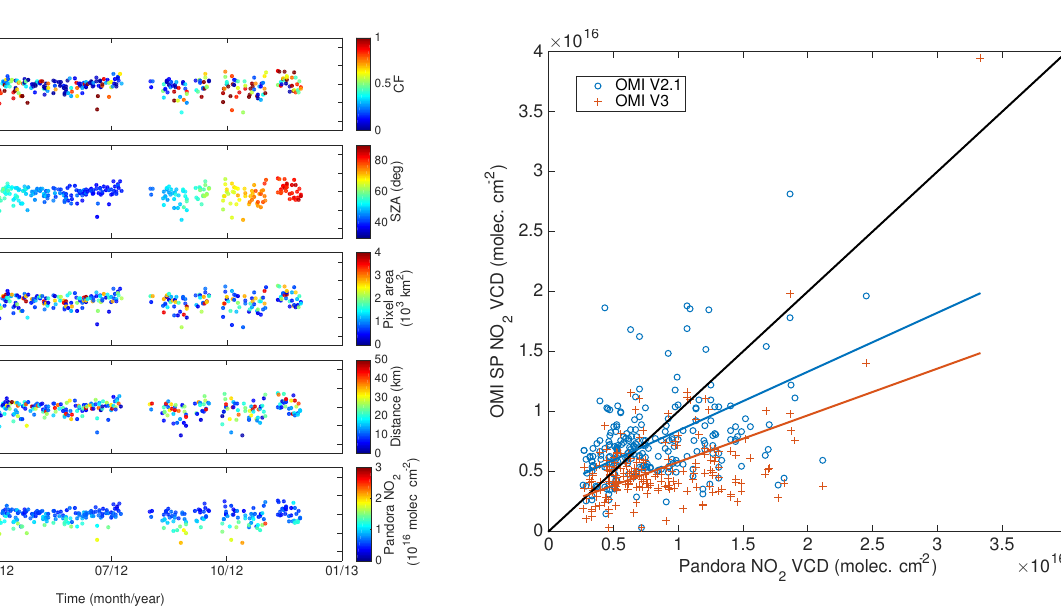
Figure 3. Difference between OMI SP and Pandora NO 2 total col- umn in Helsinki during 2012. The color scales in the different pan- els correspond to OMI CF, SZA, pixel area, distance between the actual location of Pandora instrument and the center of OMI pixel, and Pandora NO 2 total column.